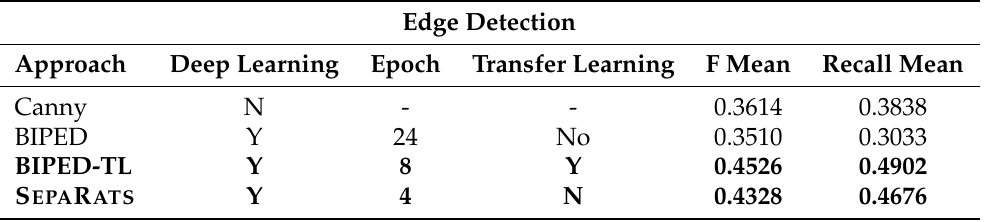
Table 2. Evaluation of different edge detection methods on our test sequence of 3600 frames, on the inner part of the overlapping objects. F-score is a support value for our decision, for more details, see text. Bold fonts indicate the results for the proposed models.